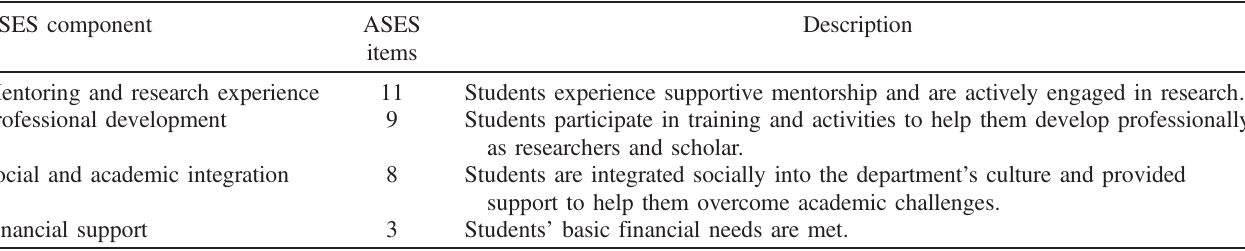
TABLE V. Summary of ASES